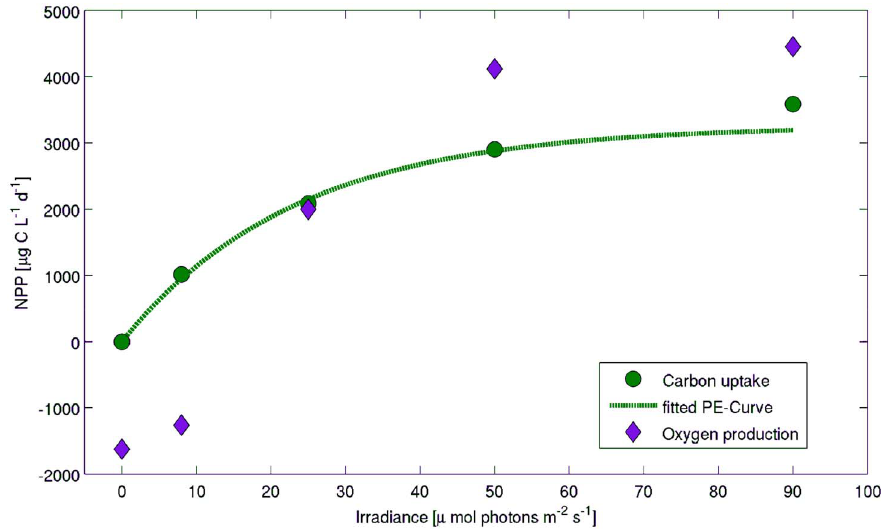
Figure 4. Photosynthesis vs Irradiance curve of Melosiraarctica algal slurry (M5). Carbon uptake measured with the 14 C radioactive isotope method (green circles) and oxygen production or consumption using optodes (purple diamonds) of the algal aggregate slurry from the Melosira arctica aggregate used for the buoyancy experiment (Fig. 5). The threshold irradiance for oxygen production is around 20 m mol photons m 2 2 s 2 1 . Oxygen rates have been transformed to carbon equivalents using the photosynthetic quotient of 1.25 to improve the visualization of the two different methods used to measure NPP.